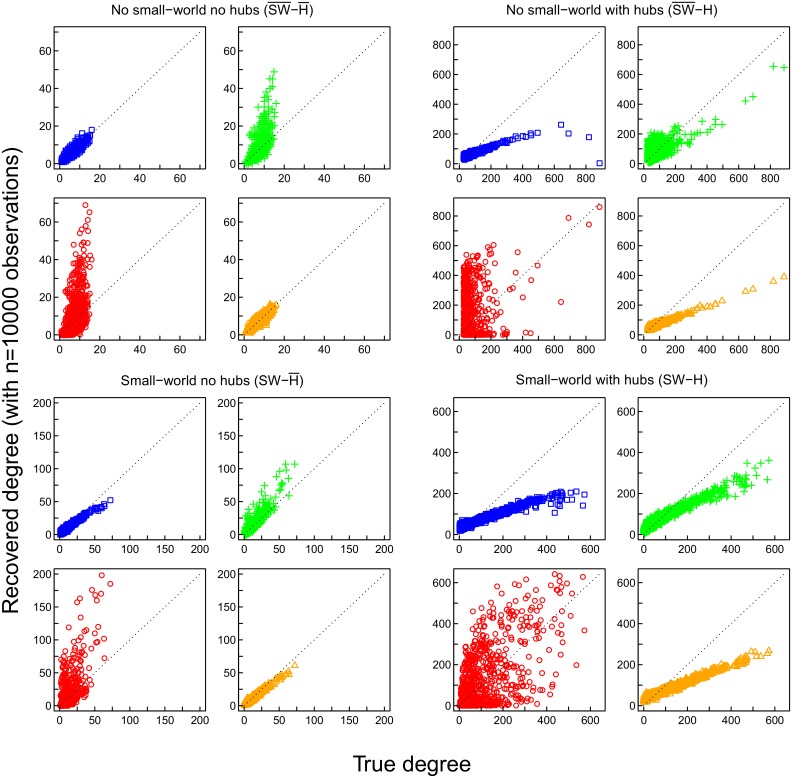
Recovery of node degrees based on 10000 observations.Scatter plots of true (x-axis) vs recovered (y-axis) node degrees of shrinkage (blue), ridge (orange), and lasso (green) estimated partial correlations, and of pairwise correlations (red).